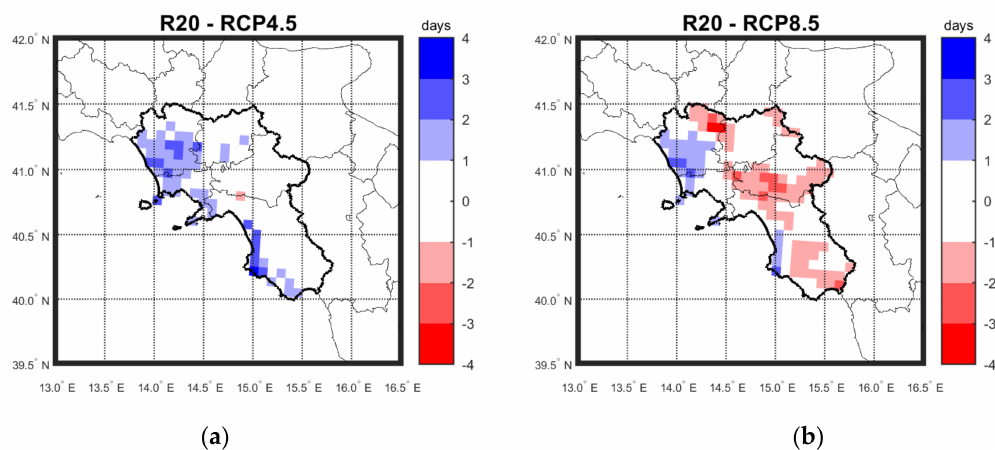
Figure 10. Maps of the difference of the average R20 value projected over the future period 2071–2100, with respect to the past period 1981–2010 under ( a ) RCP4.5 and ( b )